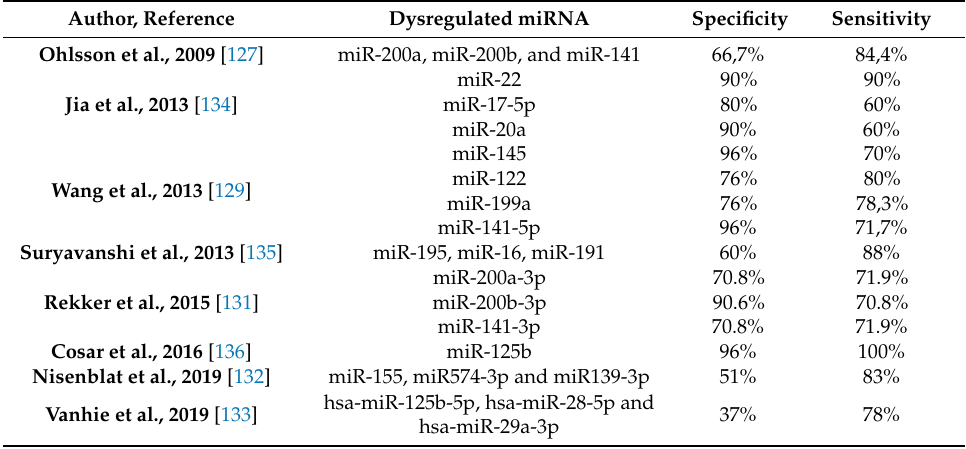
Table 1. Studies reporting the sensitivity and specificity of dysregulated miRNAs in